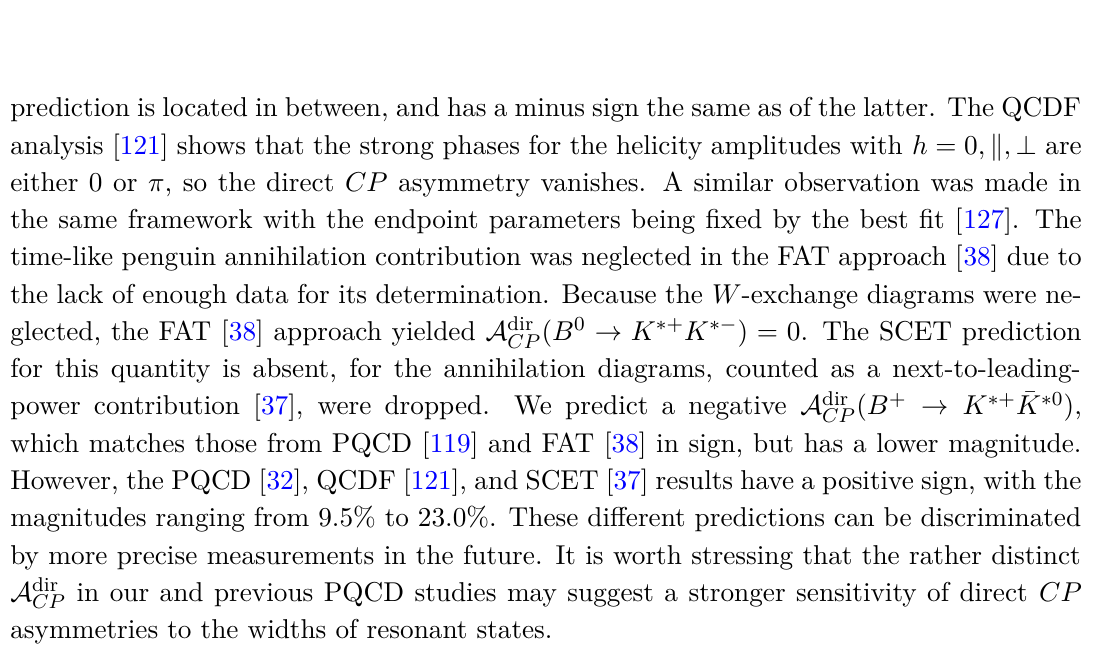
prediction is located in between, and has a minus sign the same as of the latter. The QCDF analysis [121] shows that the strong phases for the helicity amplitudes with h = 0 , k , ⊥